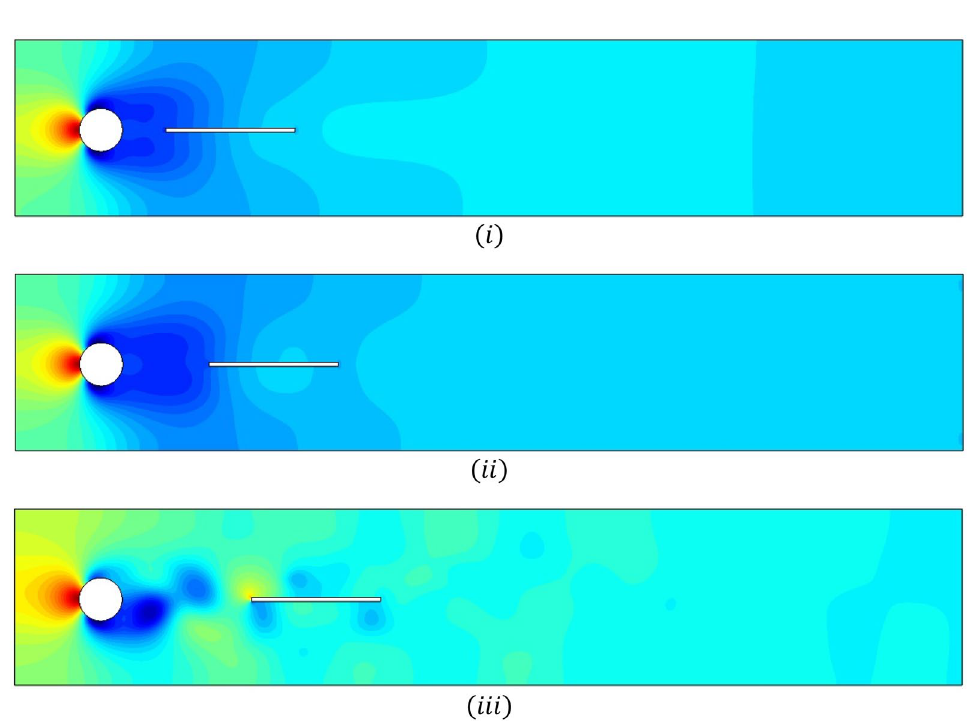
Figure 8. Influence of detached splitter plate (length L = 0.3 ) on velocity, placed at gaps ( i ) G 1 = 0.1, ( ii ) = 0.3 with Re = 100 at t = = 0.2, ( iii ) G G 3 2